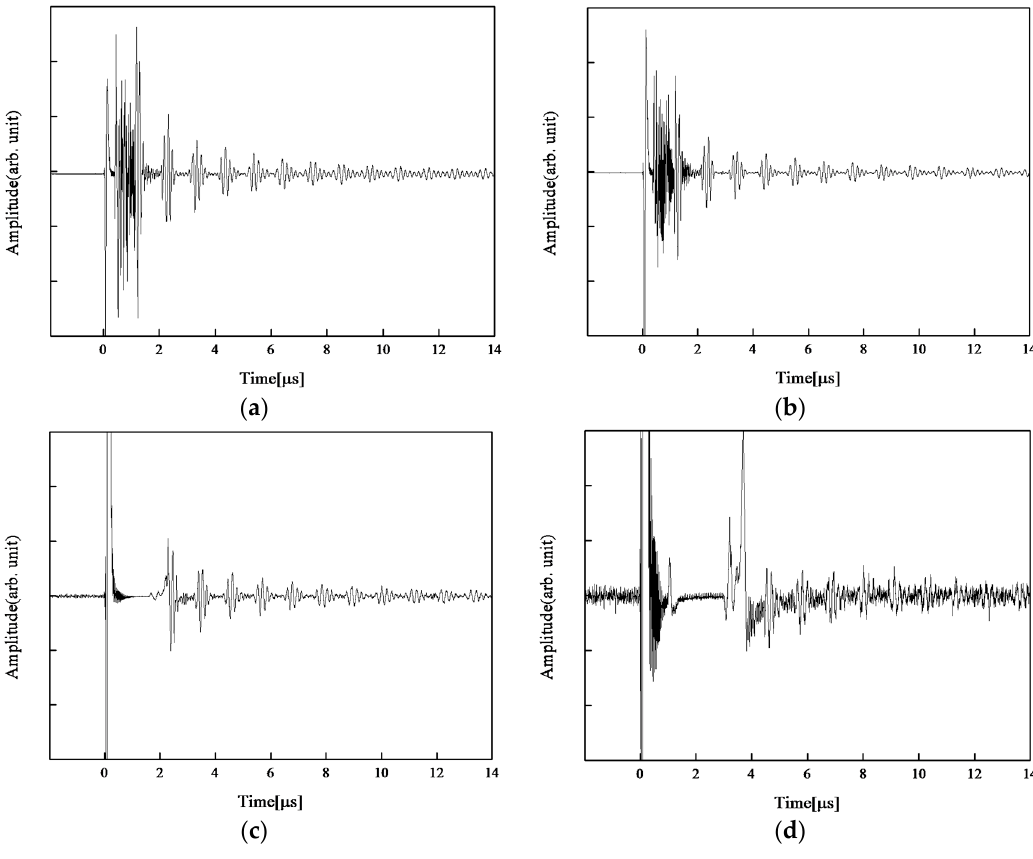
Figure 3. Ultrasonic measurement result of CBT/PZT films fabricated on 3-mm-thick 900 mm 2 titanium substrate at ( a ) 200 °C, ( b ) 400 °C, ( c ) 600 °C, and ( d ) 700 °C.